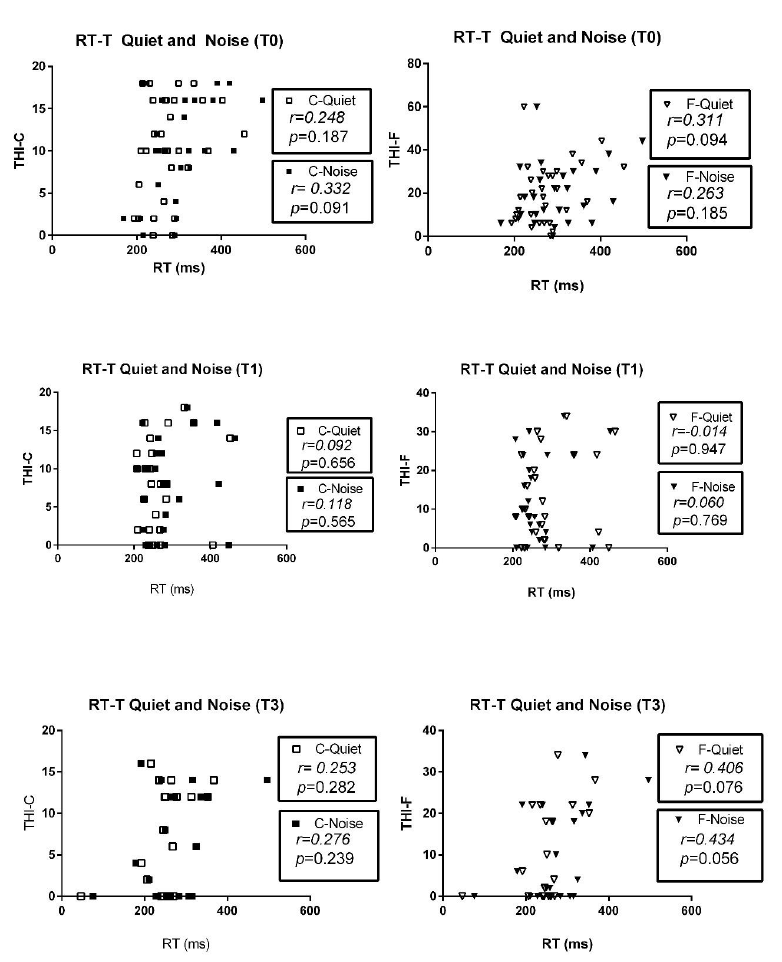
Figure A1. Scatter plots showing the correlation of THI total (T) and subscale scores (C: catastrophic; E: emotional; F: functional) with reaction time (RT); r: Spearman correlation coefficient; * p < 0.05, ** p < 001.